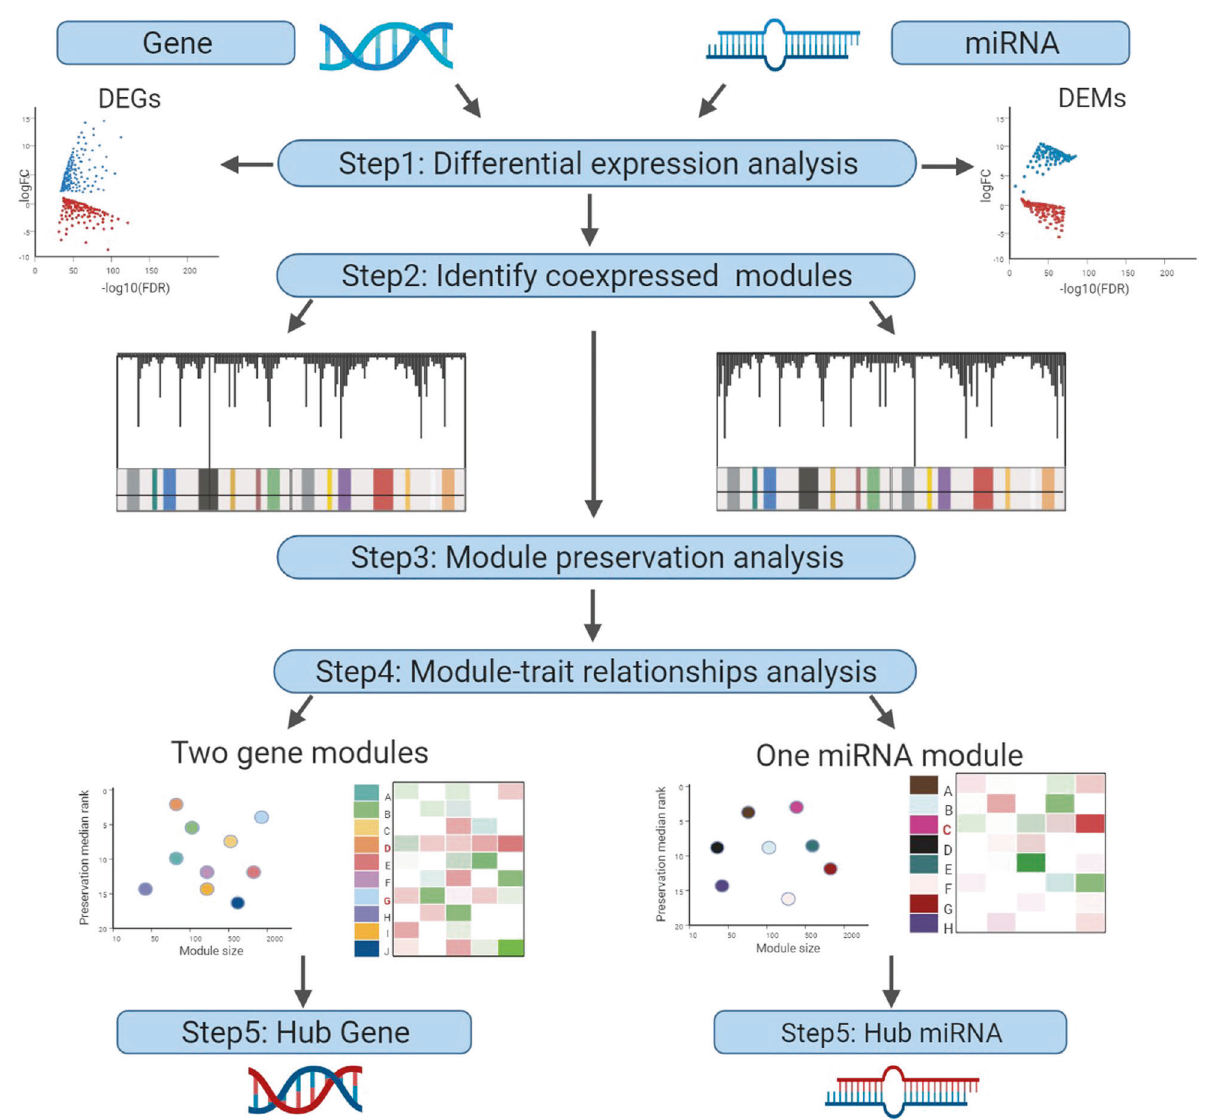
Fig. 9 The work fl ow to identify novel anticancer targets by network-based. (Created with